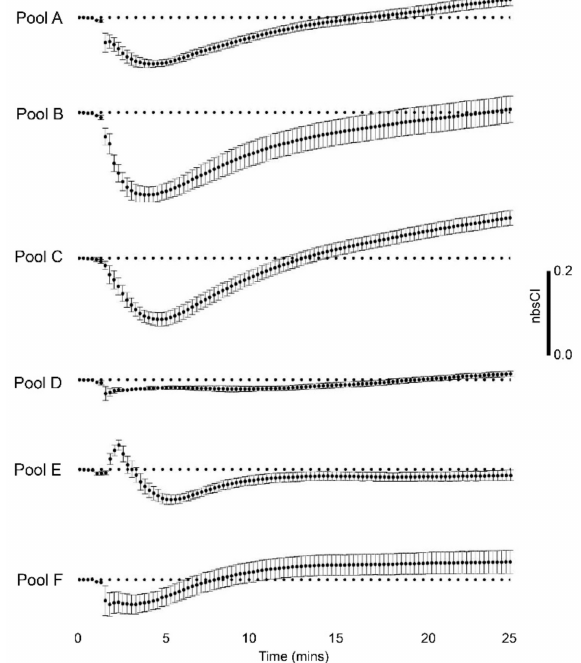
Figure 3. xCELLigence data showing average changes in GCaMP5G-RyR1-HEK293 cell monolayer impedance in response to application of venom components from Australian scorpion Hormurus waigiensis , corrected for average background control (nbsCI). Pooled venom sample A (peak samples 1, 2a, 2b); Pool B (peak samples 3, 4); Pool C (peak samples 5, 6, 7); Pool D (peak samples 8, 9, 10); Pool E (peak sample 11); Pool F (peak samples 12a, 12b).: SEM error bars shown ( n = 5–9